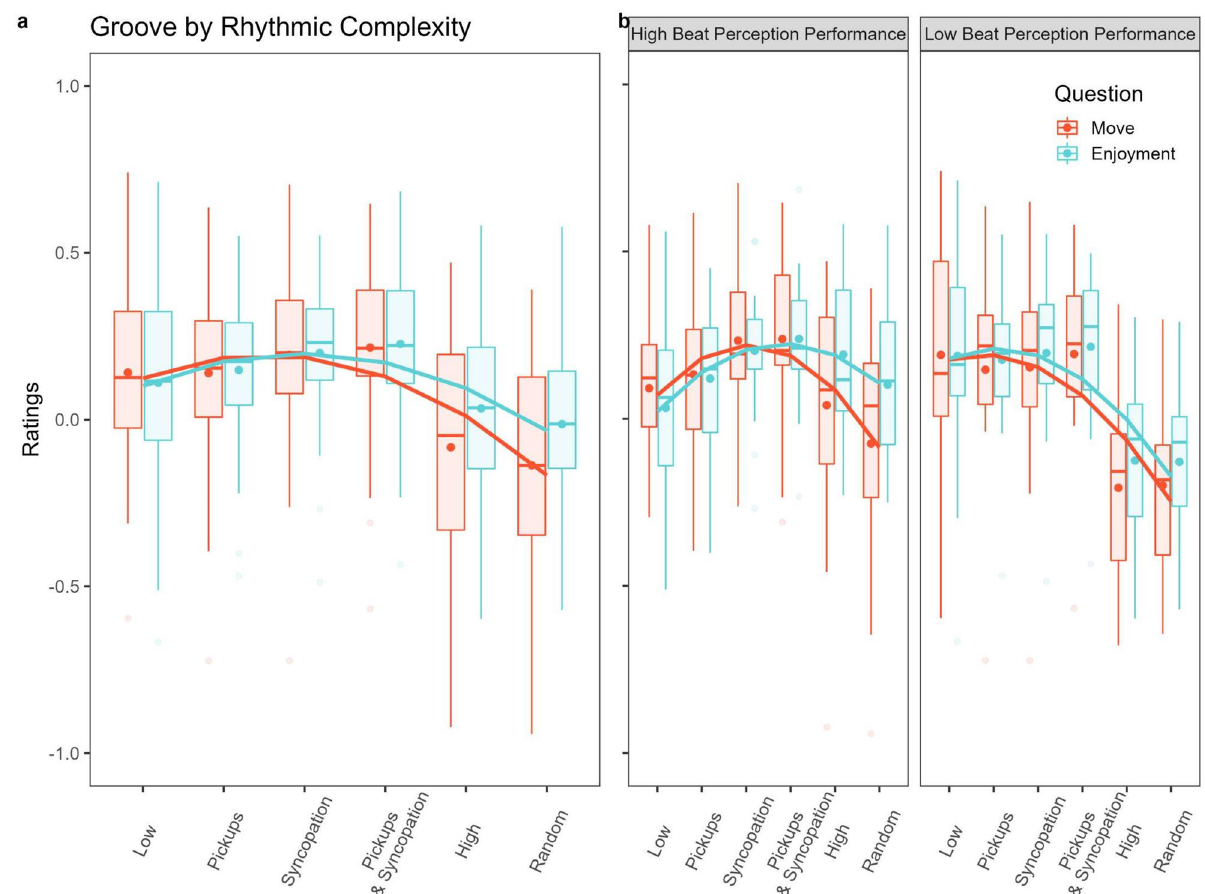
Figure 2. Quadratic models of the behavioral results across Rhythmic Complexity. ( A ) Quadratic models for Urge to Move, Enjoyment, and Perceived Arousal with individual subject predictors. Urge to Move and Enjoyment displayed significant quadratic trends. ( B ) Groove ratings across Rhythmic Complexity split by performance on the CA-BAT. There was a significant interaction between Beat Perception and the linear relationship between Rhythmic Complexity for